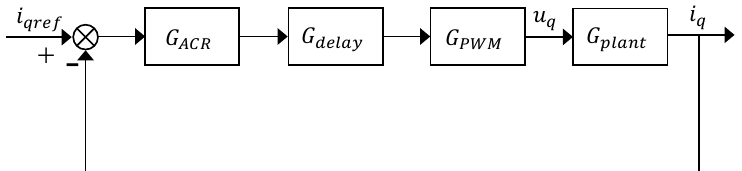
Figure 2. Current closed-loop control block